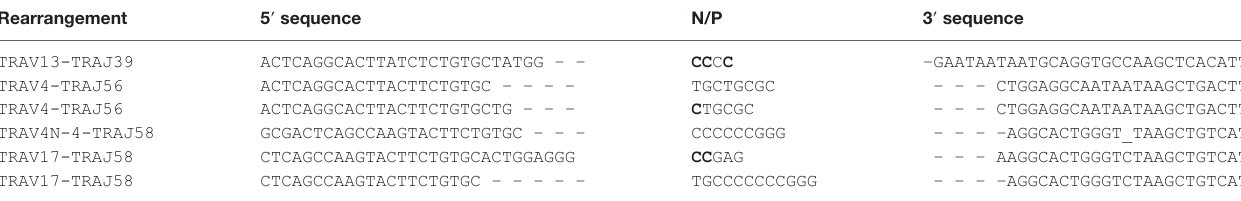
TaBle 1 | Sequences of six TCR α coding joints exhibit the features of the RAG-mediated signature.